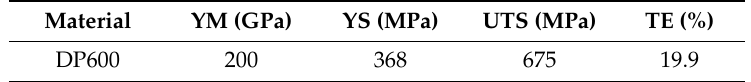
Figure 6. Dimensions of DP600 sample for in situ tensile test (mm). Table 1. Mechanical properties of DP600 steel.